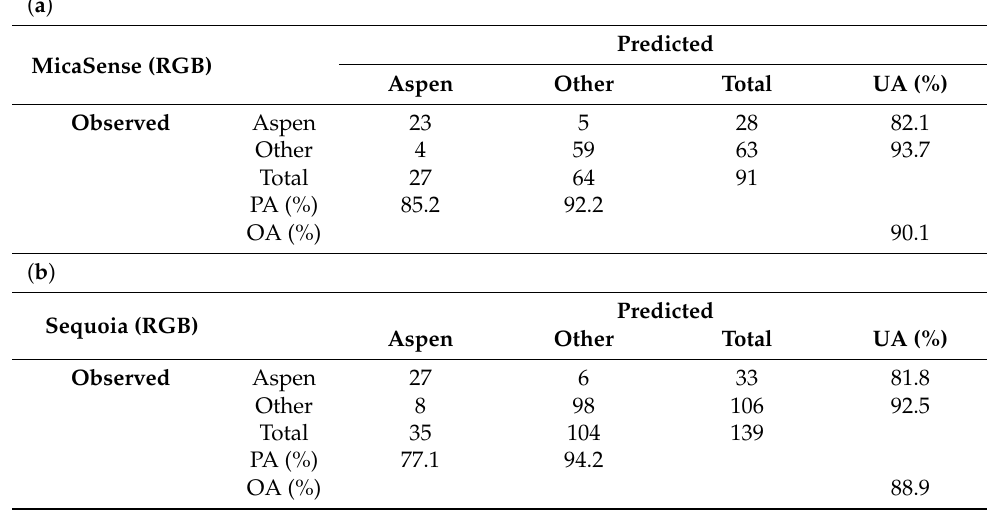
Table 3. Confusion matrix for the best SVM model for a) for the MicaSense dataset (RGB fea- tures) and b) the Sequoia dataset (RGB features). UA = user’s accuracy, PA = producer’s accuracy, OA = overall